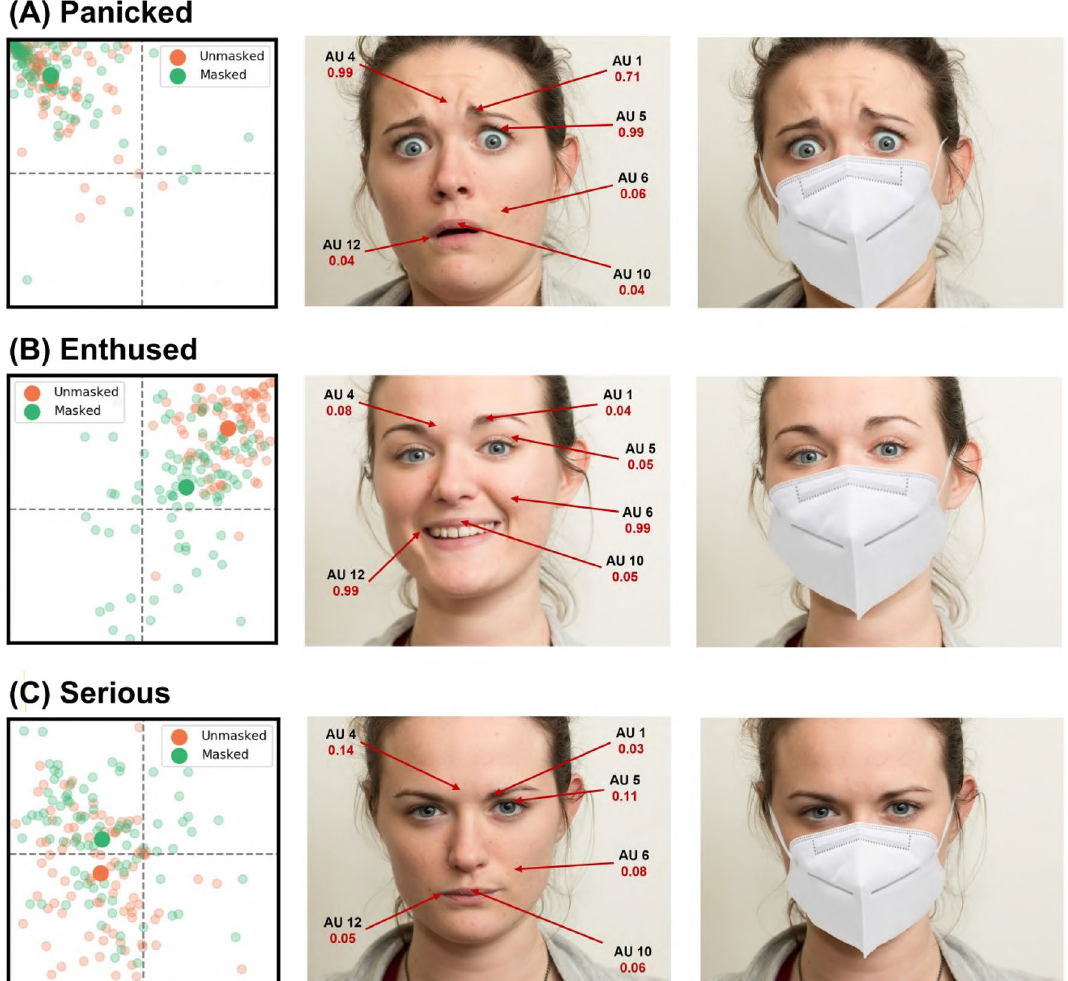
Figure 5. Comparisons of unmasked vs KN95 arousal scores (y-axis) for three mental states with variable degrees of arousal changes. Lighter datapoints are individual ratings, and darker datapoints are the mean ratings in the 2D grid. Raising the inner brow (AU 1), frowning (AU 4), and raising the upper eye lids (AU 5) are strong predictors of arousal in both conditions ( A ). Other predictors include raising the cheeks (AU 6) and the upper lip (AU 10), and smiling (AU 12), all of which are obscured by face masks, resulting in lower arousal scores ( B ). Masking was also found to intensify negative facial expressions ( C ). Face images were obtained with permission from the public McGill Face Database 32